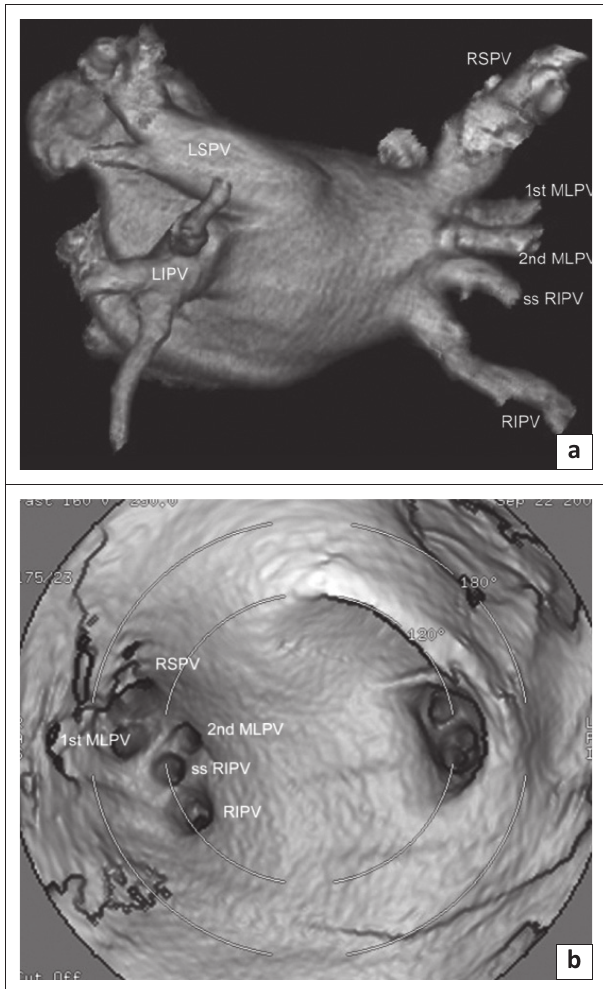
LSPV, left superior pulmonary vein; LIPV, left inferior pulmonary vein; LA, left atrium; RSPV, right superior pulmonary vein ostium; 1st MLPV, first middle lobe pulmonary vein ostium; 2nd MLPV, second middle lobe pulmonary vein ostium; RIPV, right inferior pulmonary vein; ss RIPV, superior segment right inferior pulmonary vein. FIGURE 8: Combination of supernumerary veins in another patient with atrial fibrillation, with two middle lobe veins draining directly into the left atrium, and an accessory vein draining the superior segment of the right lower lobe in addition to the right inferior pulmonary vein: (a) Three-dimensional model. Left superior pulmonary vein (LSPV), left inferior pulmonary vein (LIPV), right superior pulmonary vein ostium (RSPV), first middle lobe pulmonary vein ostium (1st MLPV), second middle lobe pulmonary vein ostium (2nd MLPV), right inferior pulmonary vein (RIPV) and accessory right inferior pulmonary vein draining the superior segment of the right lower lobe (ss RIPV); (b) Endocardial view. Right superior pulmonary vein ostium (RSPV), first middle lobe pulmonary vein ostium (1st MLPV), second middle lobe pulmonary vein ostium (2nd MLPV), right inferior pulmonary vein (RIPV) and accessory right inferior pulmonary vein draining the superior segment of the right lower lobe (ss RIPV).